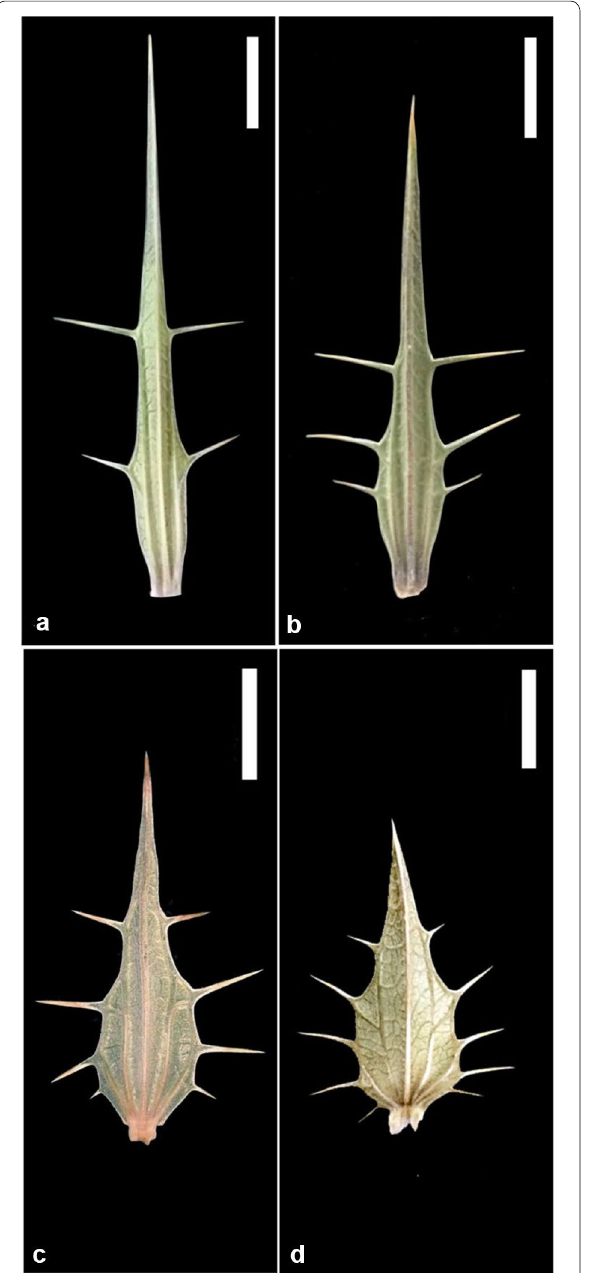
Fig. 3 Mature bracts from Blepharis plants collected from northern and southern populations in Jordan highlighting differences in numbers of veins and numbers and lengths of the stout lateral spines. a , b Bracts of a plant from the Dead Sea region (northern population). c , d Bracts of a plant from Wadi Al Yutm (southern population). Scale bars 1 cm =